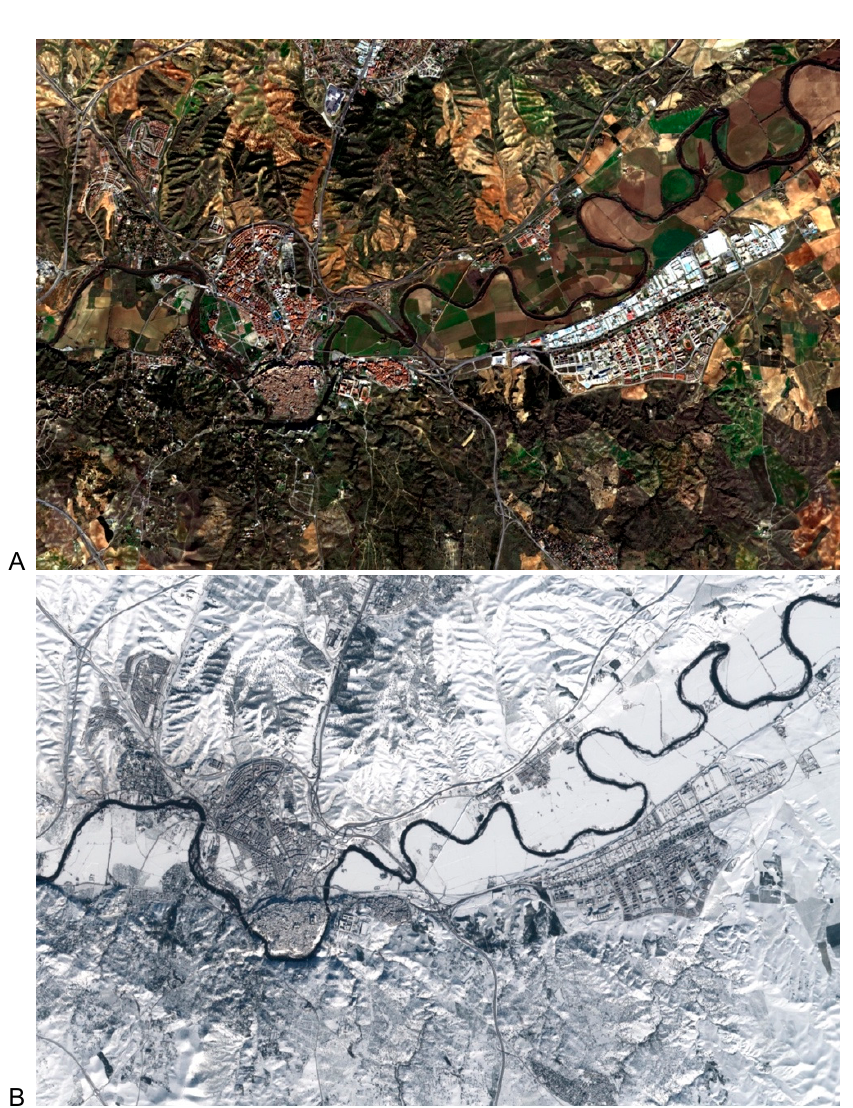
Figure 4. Sentinel 2B MSI views of Toledo city (in Castilla-La Mancha region). ( A ): 13:07Z, January 3rd; ( B ): 13:24Z January 11th. Both images are the ‘true color’, 4/3/2 bands combination.